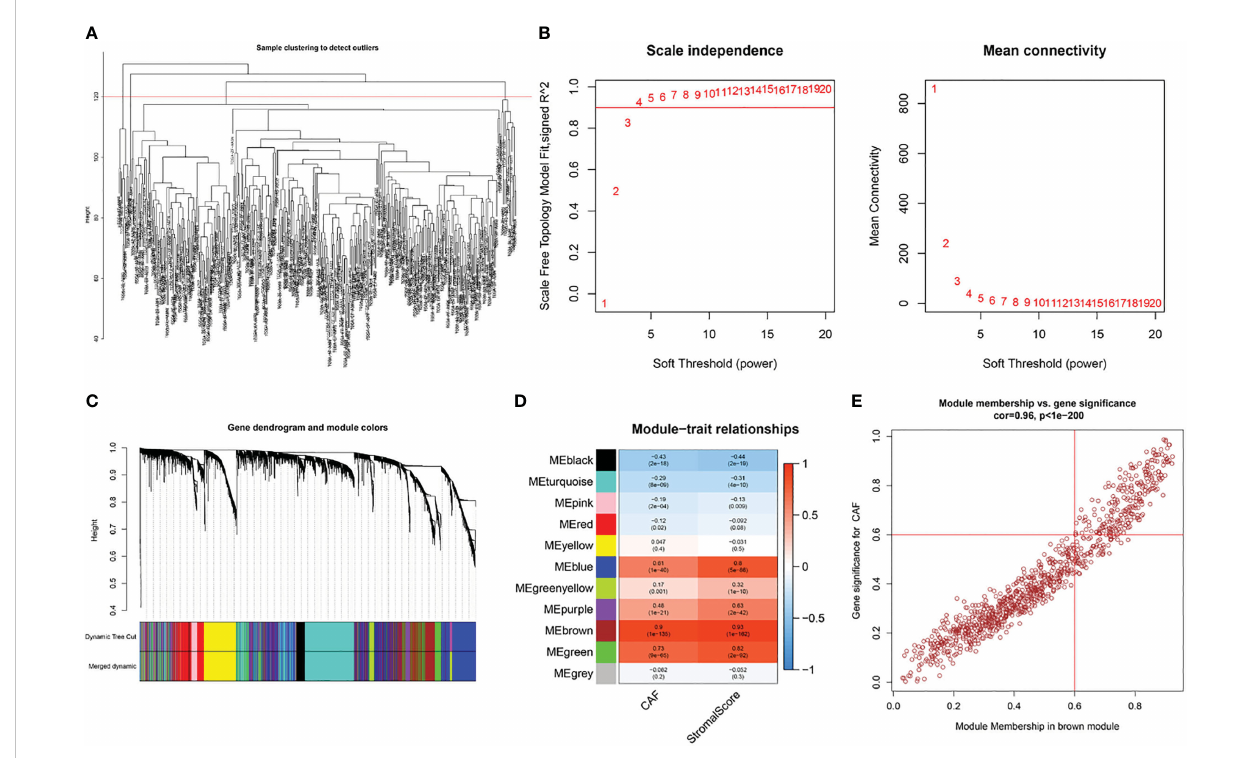
FIGURE 3 WGCNA of CAF-related genes in TCGA cohort. (A) Samples were clustered to detect outliers and sample Samples above the red line were reserved. (B) Scale-free topology model fi t (left) and mean connectivity (right) for the appropriate soft threshold power. The power selected was 4. (C) The cluster dendrogram constructing the gene modules and module merging. (D) Correlation analysis between the module and CAF fraction and StromalScore. (E) Correlation between GS and MM in the brown